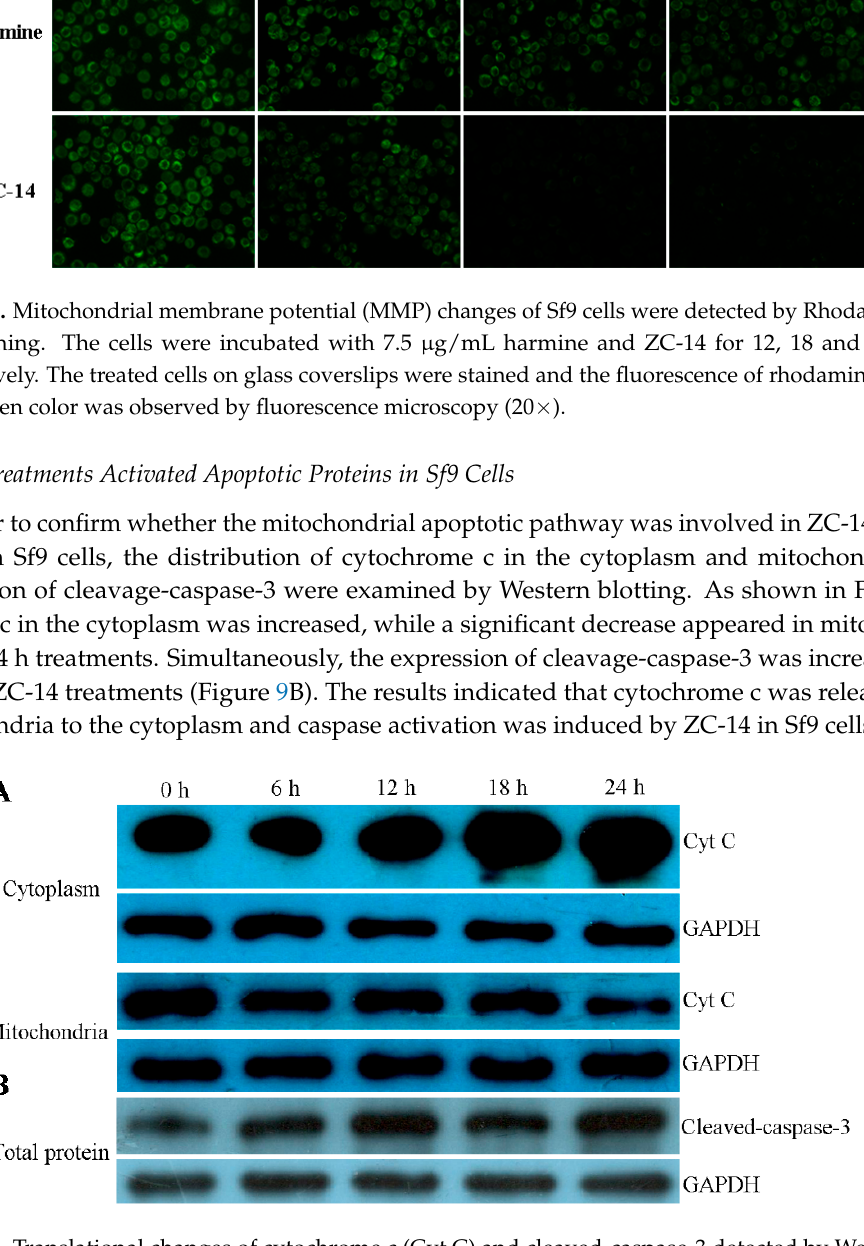
Figure 9. Translational changes of cytochrome c (Cyt C) and cleaved-caspase-3 detected by Western blot analysis. The cells were treated with 7.5 μ g/mL ZC-14 for 6, 12, 18 and 24 h, respectively. ( A ) The levels of cytochrome c in cytosol and mitochondria. ( B ) The levels of cleaved-caspase-3. GAPDH was used as an internal control.